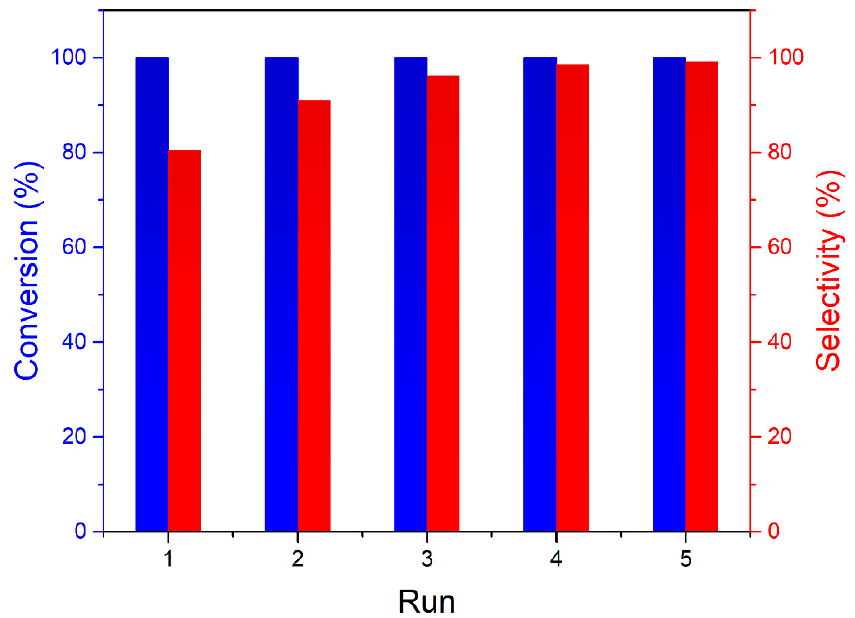
Figure 3. Conversion of furfural and selectivity for the furfuryl alcohol over the AC-Ru nanocatalyst in five consecutive runs. (More details in Supplementary Materials Section S1) Reaction conditions: AC-Ru (48 mg), furfural (0.1 g, 1.04 mmol), 2-propanol (0.8 mL), H 2 , 1 MPa, 90 ◦ C, 3